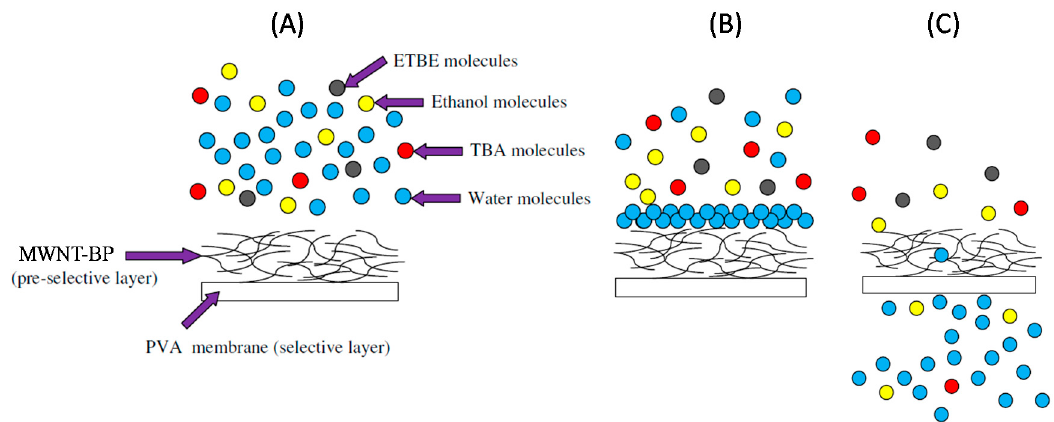
Figure 9. Schematic illustration of pervaporation of an azeotropic mixture. ( A ) Feed solution containing a mixture of ethyl tert -butyl ether (ETBE), tert -butyl alcohol (TBA), and ethanol; ( B ) intermediate; and ( C ) final stages of pervaporation using an MWNT/PVA BP. Reproduced with permission from Reference [90]. Copyright Elsevier, 2014.